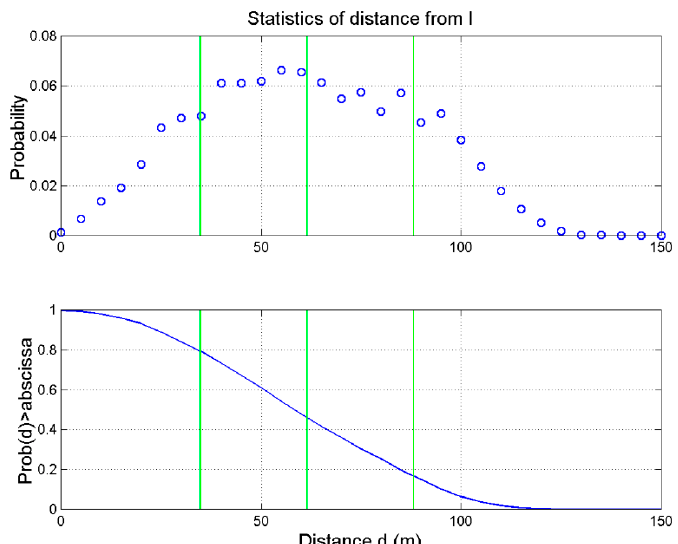
Figure 12. Upper panel : Probability density of the distance d (m) between the “stick point” and the Anonymous Hypogeum “I”, southern angular range in step (5). Lower panel : Probability distribution that the distance exceeds the value indicated in abscissa. The vertical green lines mark ± 1 standard deviation values (i.e, 27